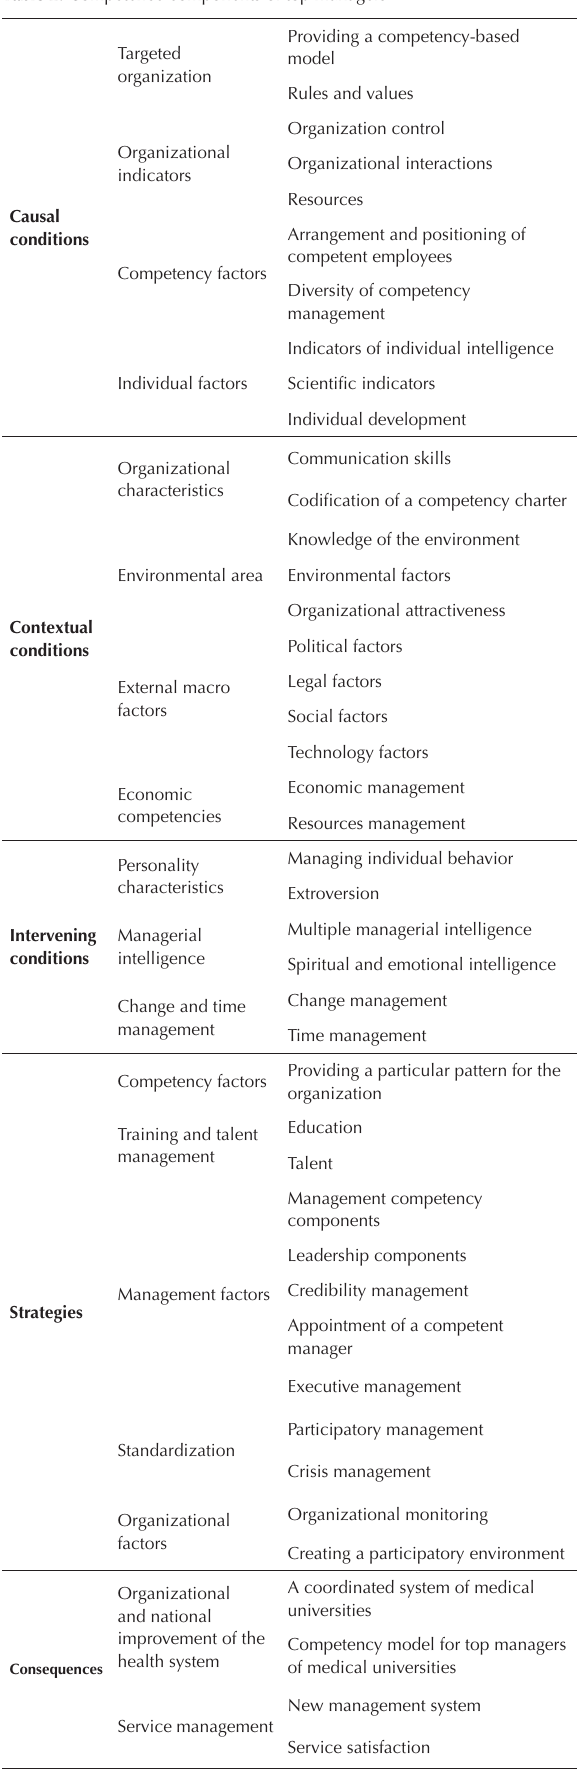
Table 2. Competence components of top